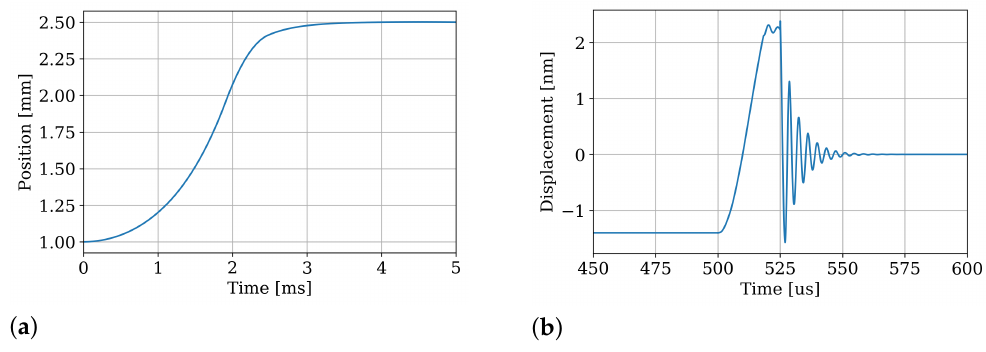
Figure 10. The kick and catch actuation at system-level. ( a ) The sphere’s vertical position over time for the full duration of 5ms, showing a clear catch at 2.5mm. ( b ) Vertical position of the center node for 450µs to 600µs, illustrating the kick